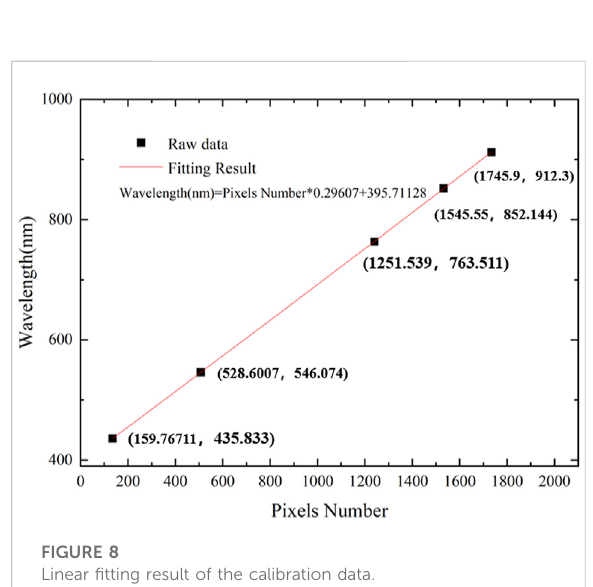
FIGURE 8 Linear fi tting result of the calibration data.